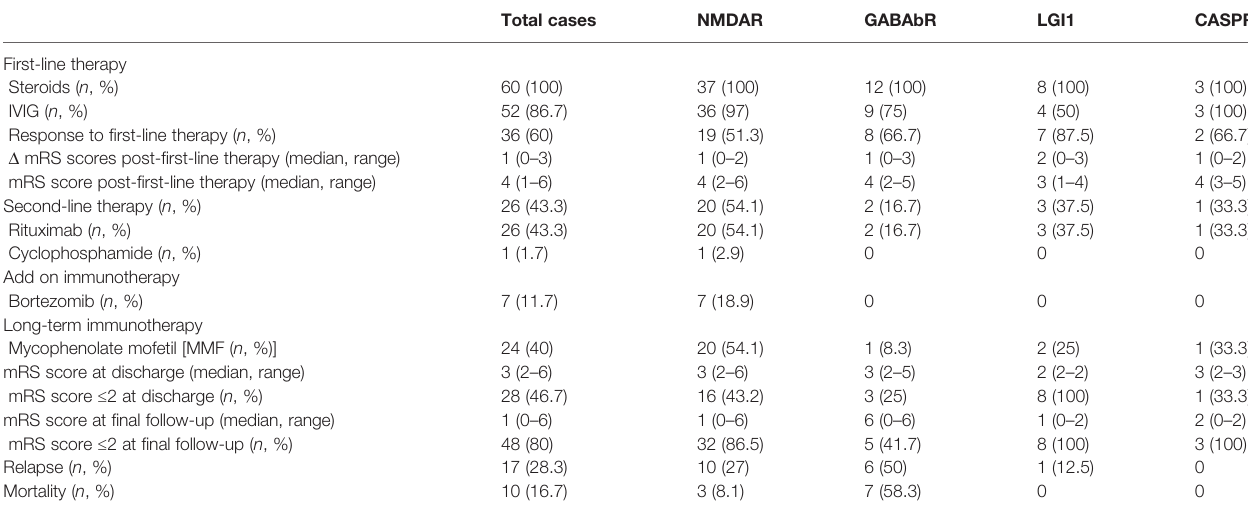
TABLE 2 | Immunotherapy and follow-up of patients.